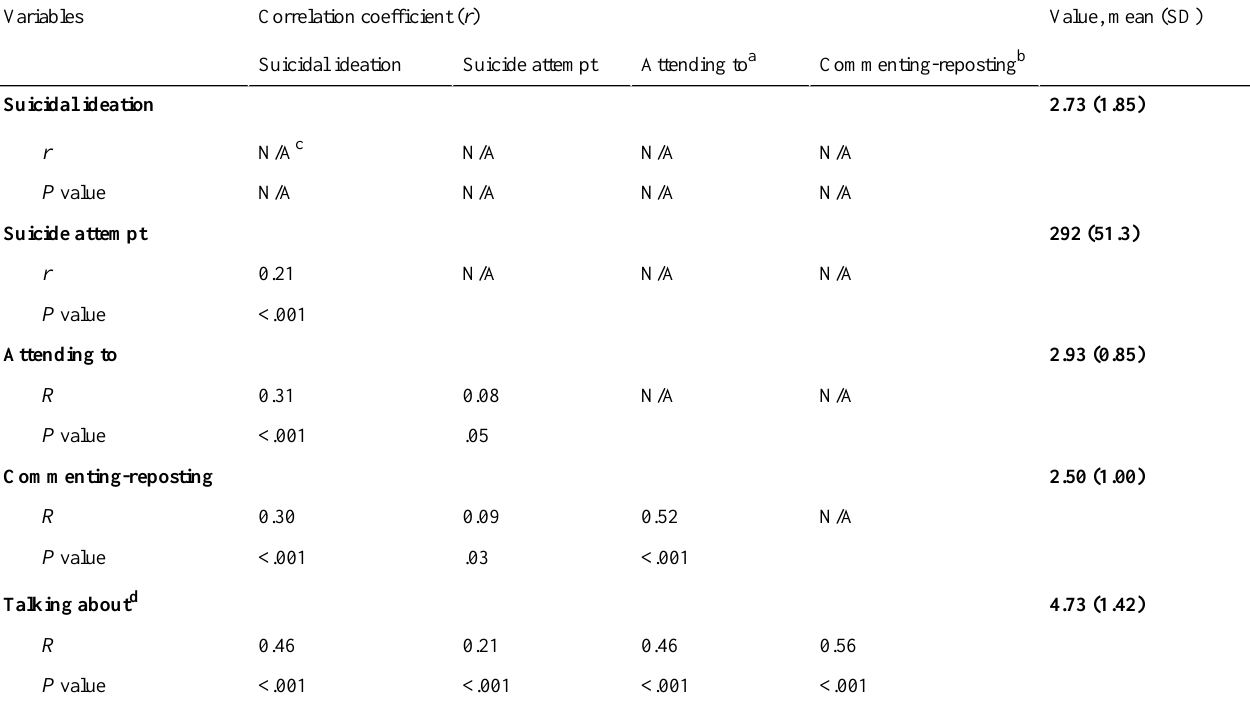
Table 4. Descriptive statistics and bivariate correlations of the study variables.